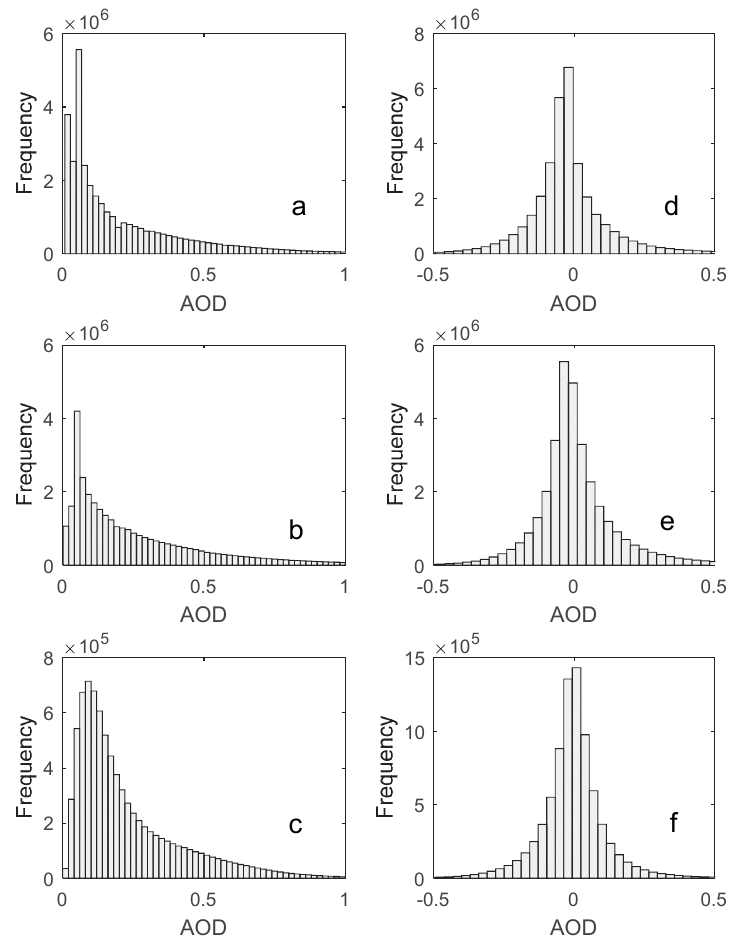
Figure 3. Histograms of ( a ) original Deep Blue (DB) AODs, ( b ) original Dark Target (DT)_DB Combined AODs, ( c ) original Multiangle Imaging SpectroRadiometer (MISR) AODs, ( d ) detrended DB AODs, ( e ) detrended DT_DB_Combined AODs, ( f ) detrended MISR AODs.